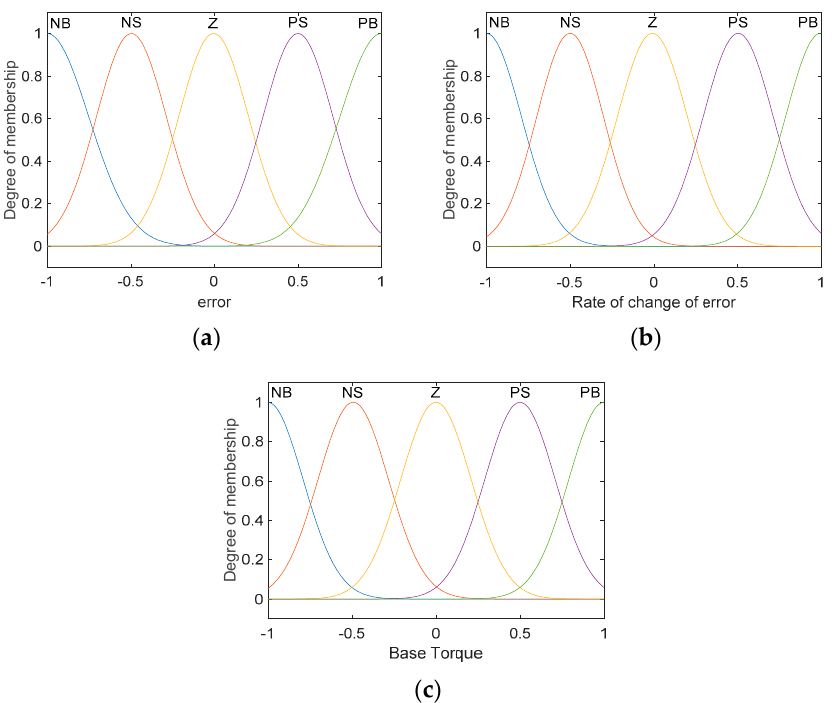
Figure 4. The membership functions of ( a ) the error, ( b ) rate change of the error, and ( c ) base toque. Table 2. Fuzzy rules.